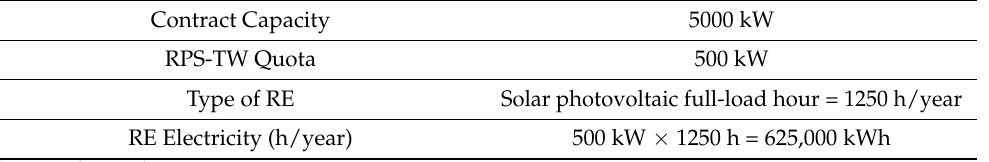
Table 9. Sample calculation: RE electricity and certificates option.